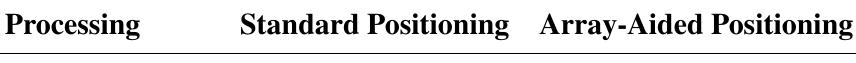
Table 3. Empirical instantaneous ambiguity resolution success rate (%) for baseline estimation using static data (20-m baseline).